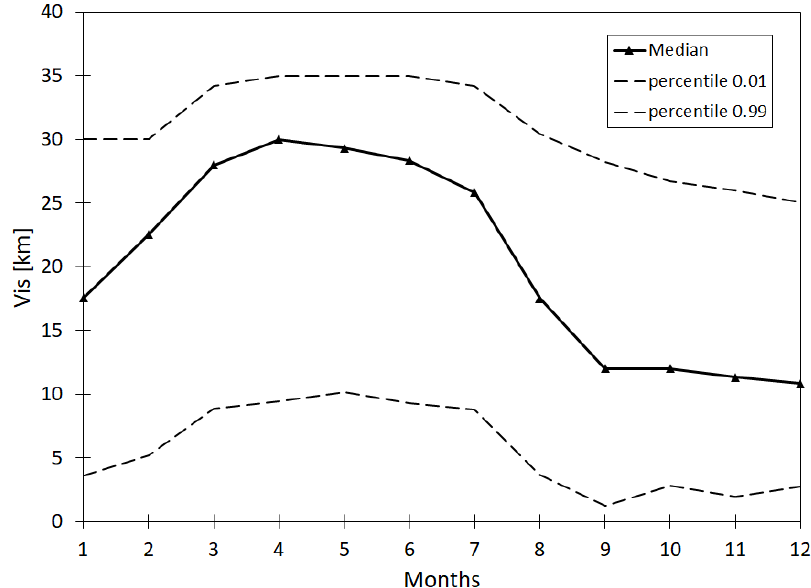
Figure 4. Variability of visibility (Vis) over the annual cycle.